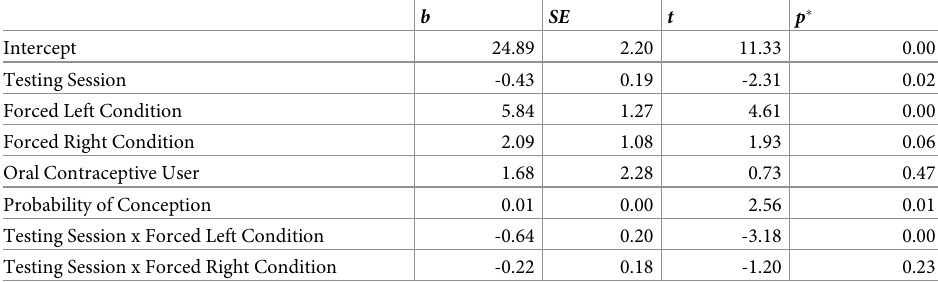
Table 5. Parameter estimates from the mixed-effects model for error